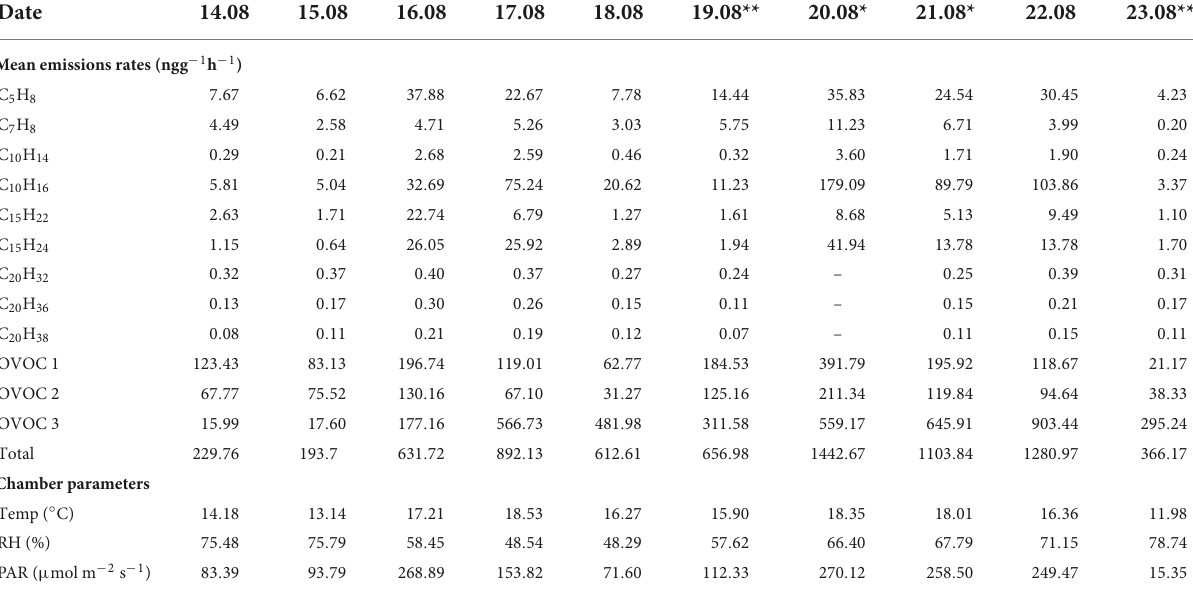
TABLE 1 Daily mean emission rates (ngg − 1 h − 1 ) of different compounds and mean of observed chamber parameters. The emission rates of oxygenated compounds (OVOC) classes are sum of the mean of individual compounds in the respective